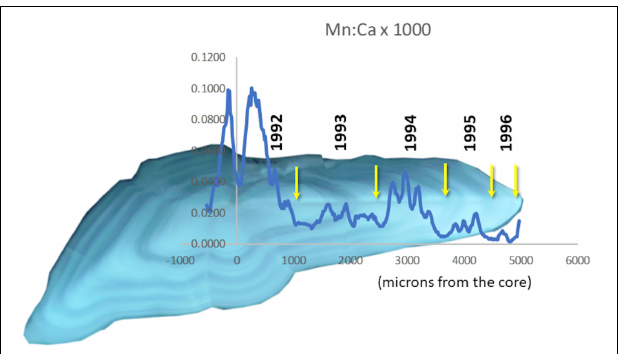
FIGURE 3 | Transect of Mn/Ca overlaid on an otolith from a cod that lived through a period of very low hypoxia in the Baltic. Annuli are marked with yellow arrows. Hypoxia reached a minimum in 1993 ( Figure 1B